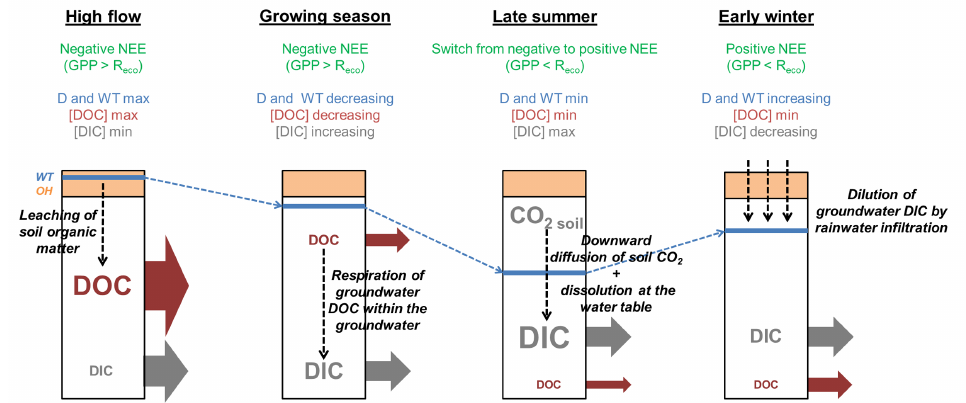
Figure 7. Conceptual model at the vegetation–soil–groundwater–stream interface in sandy ecosystems with shallow groundwater. OH, WT and D are the organic horizon of the soil, the water table and the drainage, respectively. Hydro-biogeochemical processes are represented by dashed arrows. Carbon exports are represented in full arrows; the thickness of the arrow indicates the magnitude of flux.